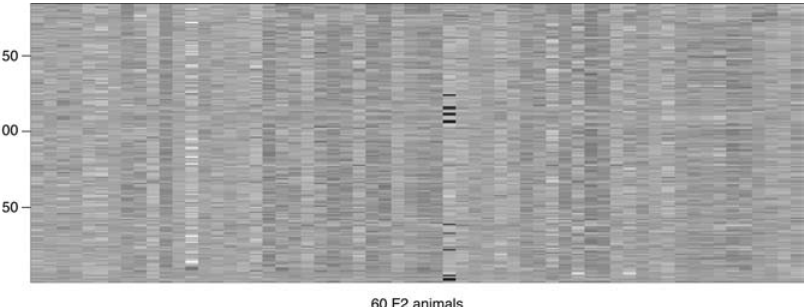
Figure 4. Lipid Metabolism Pathway Genes Show Coordinated Expression across the F 2